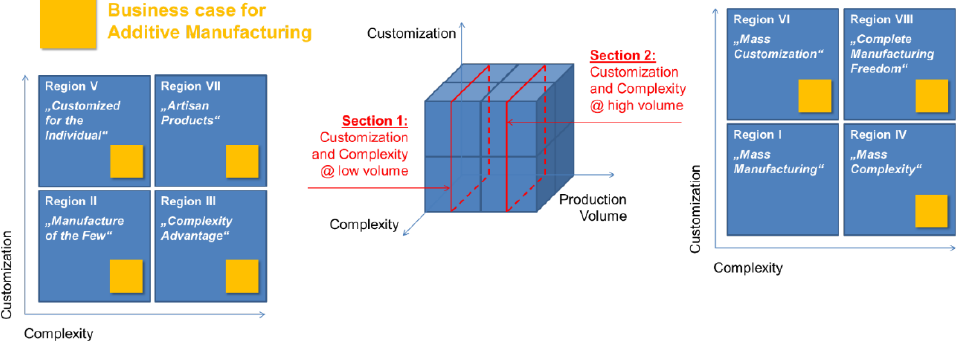
Figure 5. The defining regions of product characteristics in production volume-complexity-customization space and the respective potential of AM techniques according to Conner et al. [66].